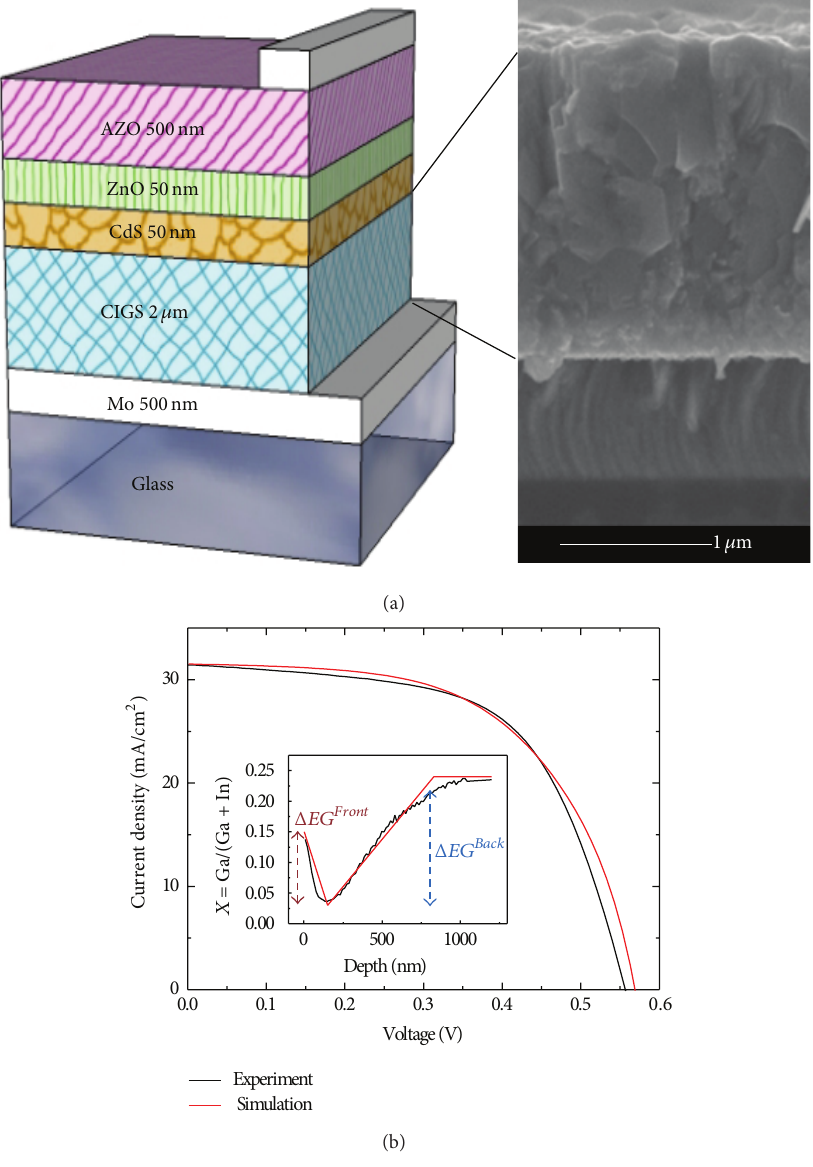
Figure 1: (a) Cell structure and cross-sectional SEM photographs of a CIGS/Mo solar cell fabricated on Mo-coated soda-lime glass substrate. (b) Simulation result from device modeling with baseline parameters including a grading bandgap compared with experimental J-V curve and SIMS data.